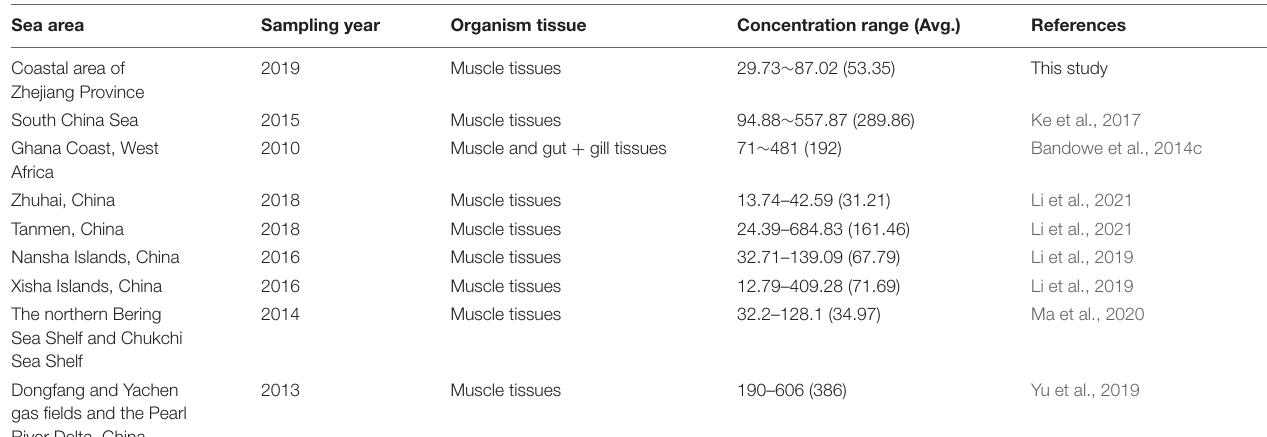
TABLE 1 | Comparison of PAH concentrations (ng/g dw) in the marine organisms from sea areas. Sea